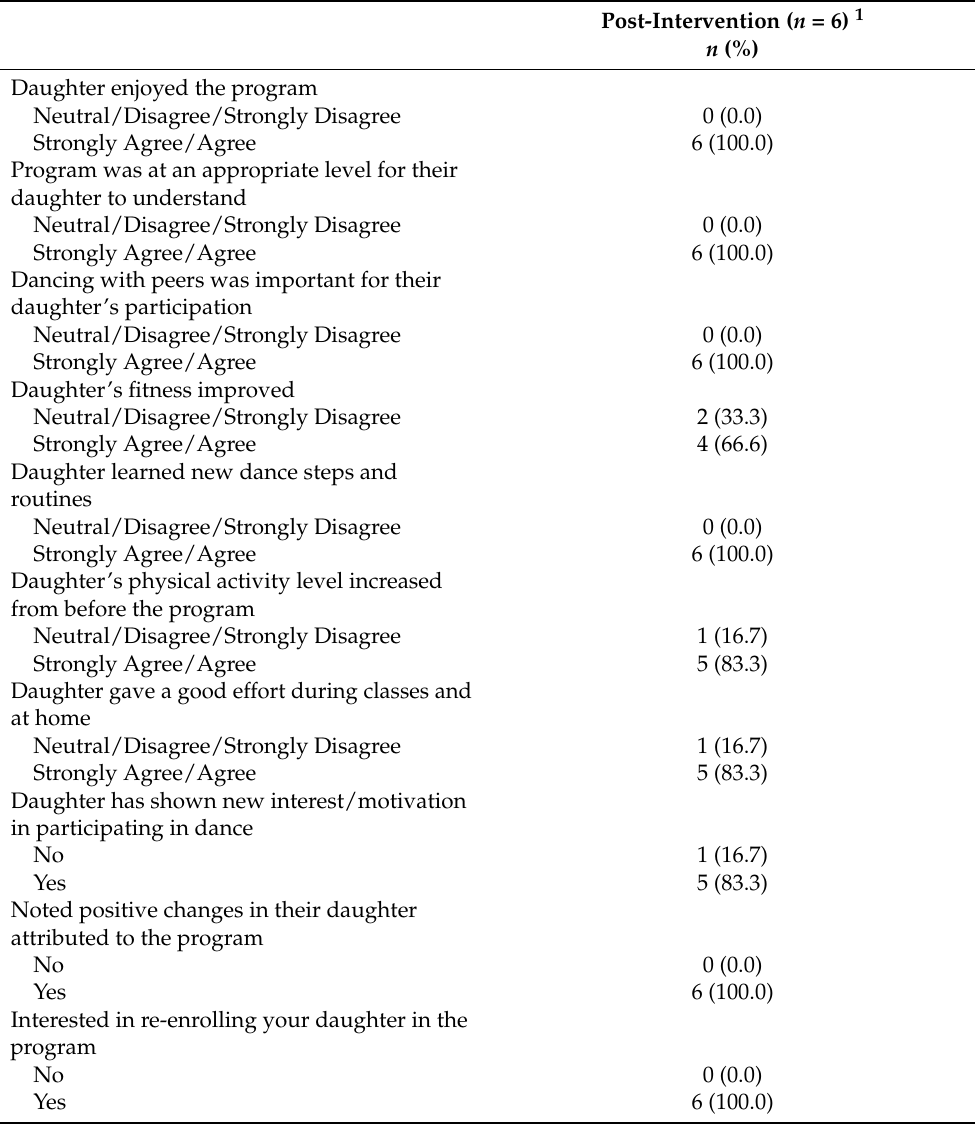
Table 5. Parent satisfaction with the dance program at post-intervention at site B